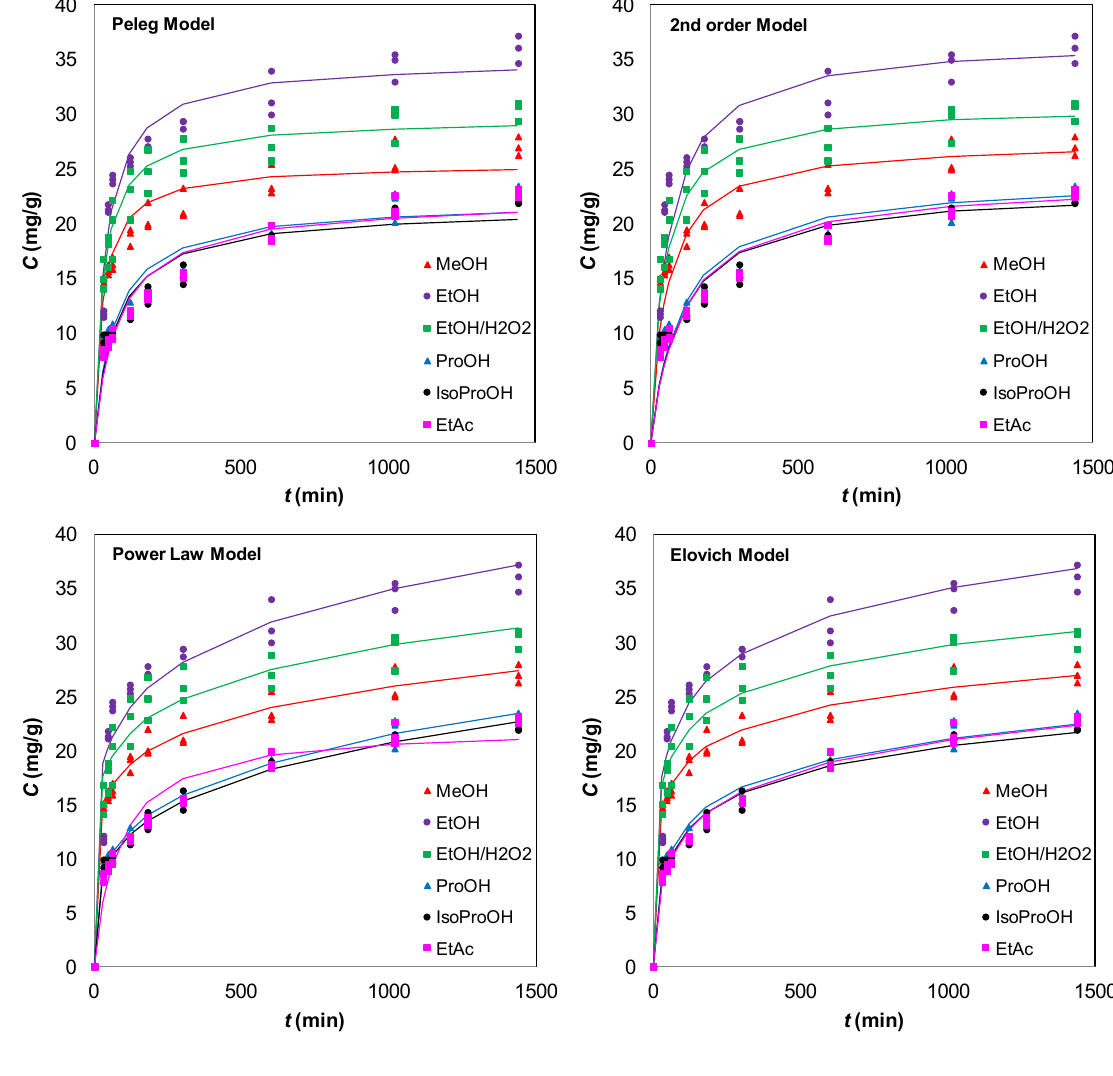
Figure 2. Kinetics of phenolics extraction from olive leaves with different solvents at 25